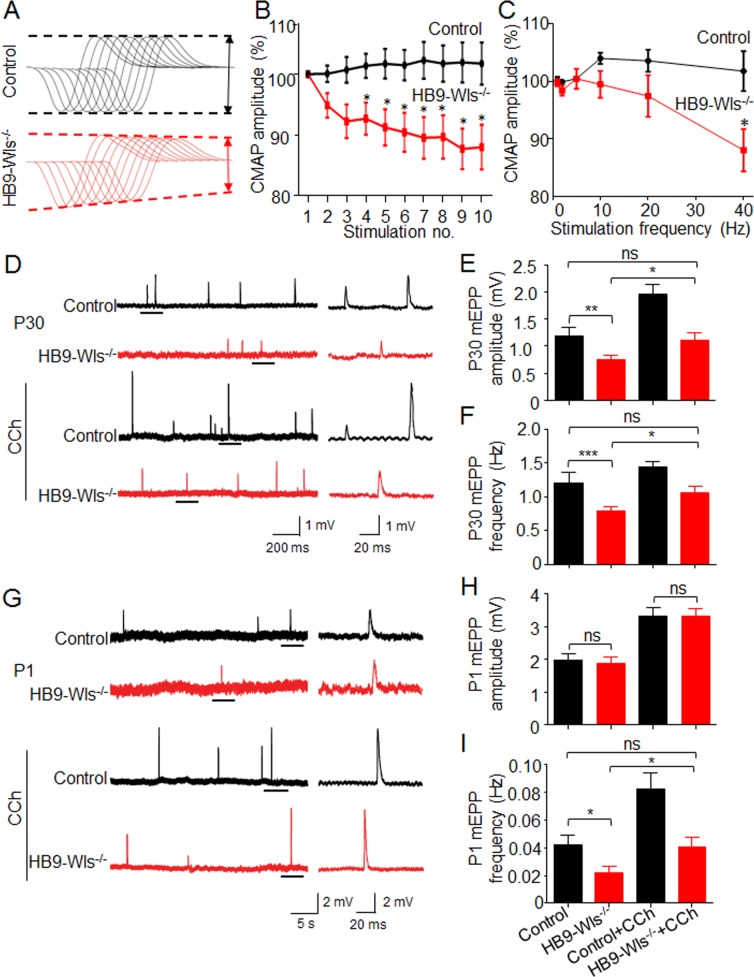
Wls loss in motoneuron impairs neurotransmission initially from presynapse.(A) CMAPs were recorded in gastrocnemius from P30 mice in response to a train of 10 submaximal stimuli at different frequencies. The first stimulus response in control mice was designated as 100%. Representative 10 CMAP traces, shown stacked in succession for better comparison. (B) Reduced CMAP amplitudes at 40 Hz in HB9-Wls-/- mice. n = 4 mice per group. Two-way ANOVA, *p<0.05. (C) CMAP amplitudes of the tenth stimulation at different stimulation frequencies. n = 4 mice per group. Two-way ANOVA, *p<0.05. (D) Representative mEPP traces from P30 mice. mEPPs were recorded from hemidiaphragms. Traces underlined on the left are enlarged on the right. (E) Reduced mEPP amplitudes in mutant mice and CCh effects at P30. F(2, 9)=13.56, ns, p>0.05, **p<0.01. n = 4 mice per group, 5–6 muscle fibers per mouse; One-way ANOVA. (F) Reduced mEPP frequencies in mutant mice and CCh effect at P30. F(2, 9)=14.2, ns, p>0.05, **p<0.01, *p<0.05, n = 4 mice per group, 5–6 muscle fibers per mouse; One-way ANOVA. (G) Representative mEPP traces from P1 mice. (H) Comparable mEPP amplitude between two genotypes and CCh effect at P1. F(2, 9)=63.07, ns, p>0.05, ***p<0.001. n = 4 mice per group, 5–6 muscle fibers per mouse; One-way ANOVA. (I) Reduced mEPP frequency in mutant mice and CCh effect at P1. F(2, 9)=12.87, ns, p>0.05, **p<0.01. n = 4 mice per group, 5–6 muscle fibers per mouse; One-way ANOVA.